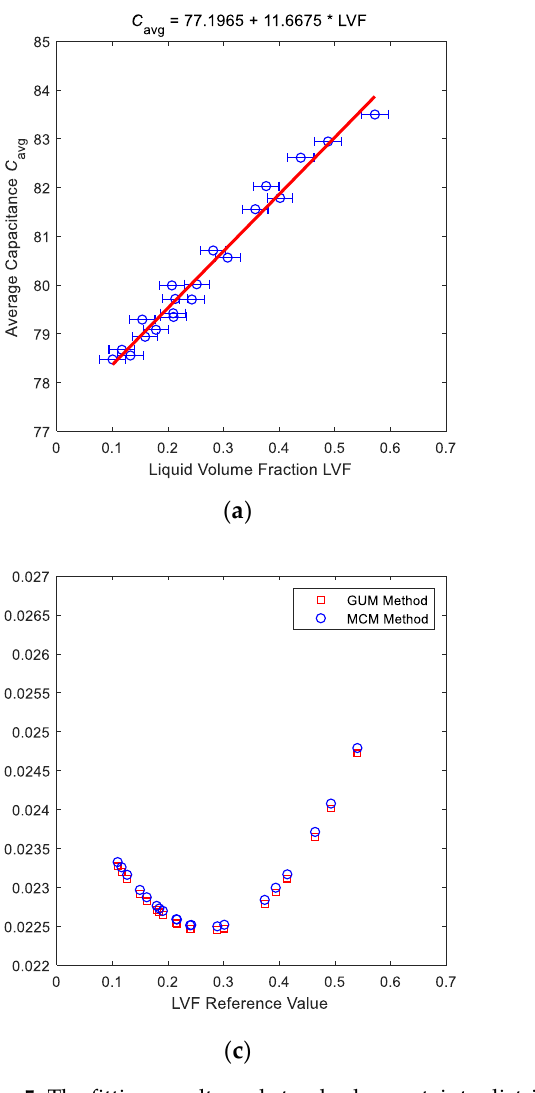
Figure 5. The fitting results and standard uncertainty distributions of important intermediate variables of the “Cap + CC” method: ( a ) the fitting results of the liquid volume fraction (LVF); ( b ) the fitting results of the total volume flowrate 𝑄 𝑡𝑜𝑡 ; ( c ) the standard uncertainty distributions of the liquid volume fraction LVF; ( d ) the standard uncertainty distributions of the total volume flowrate 𝑄 𝑡𝑜𝑡 .